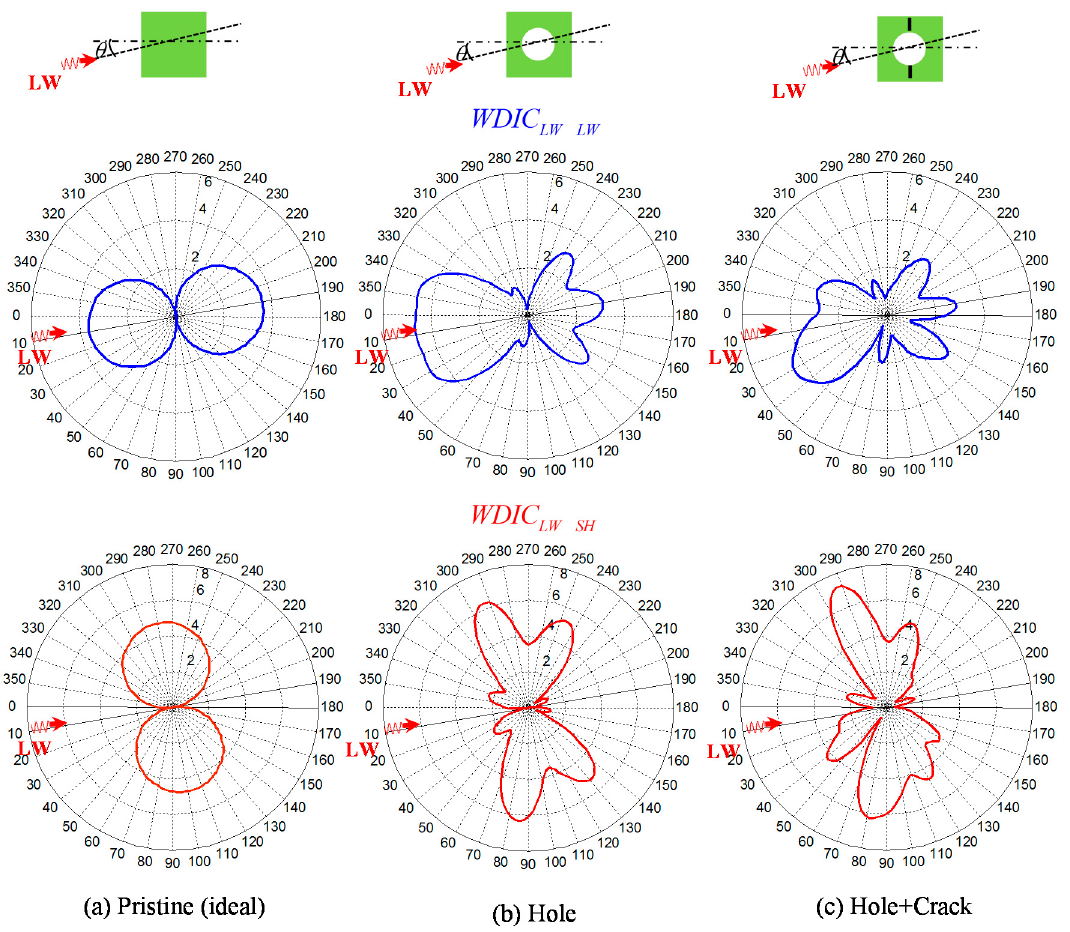
Figure 5 . Alteration of wave damage interaction coefficient (WDIC) profiles of scattered Lamb and shear horizontal (SH) waves with different damage conditions: ( a ) Pristine; ( b ) Hole; ( c ) Hole + Crack.